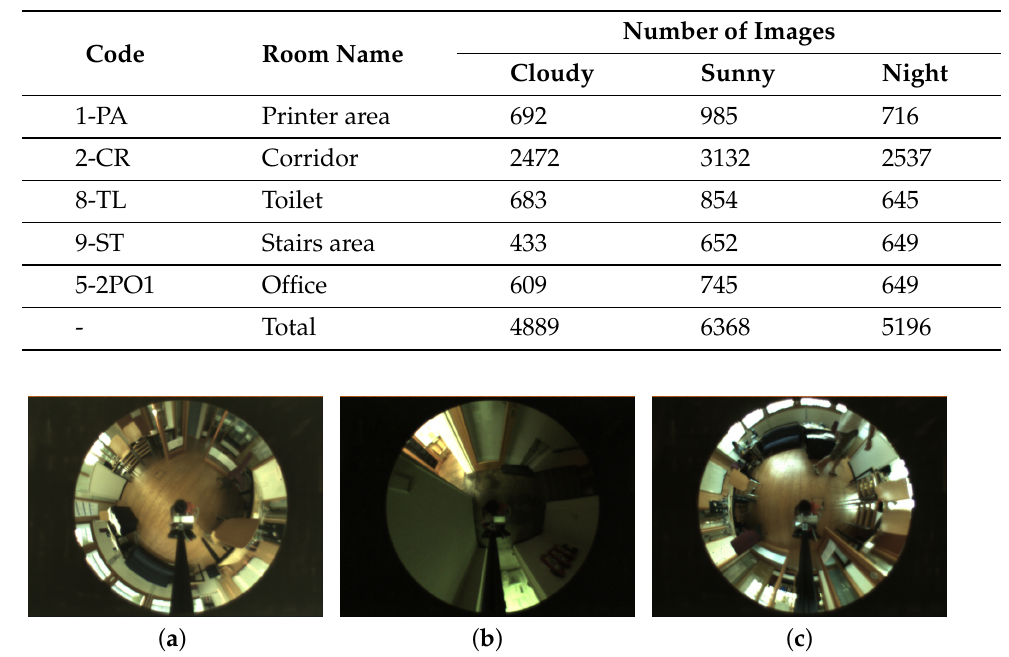
Table 1. Number of images for each room and for each illumination condition.